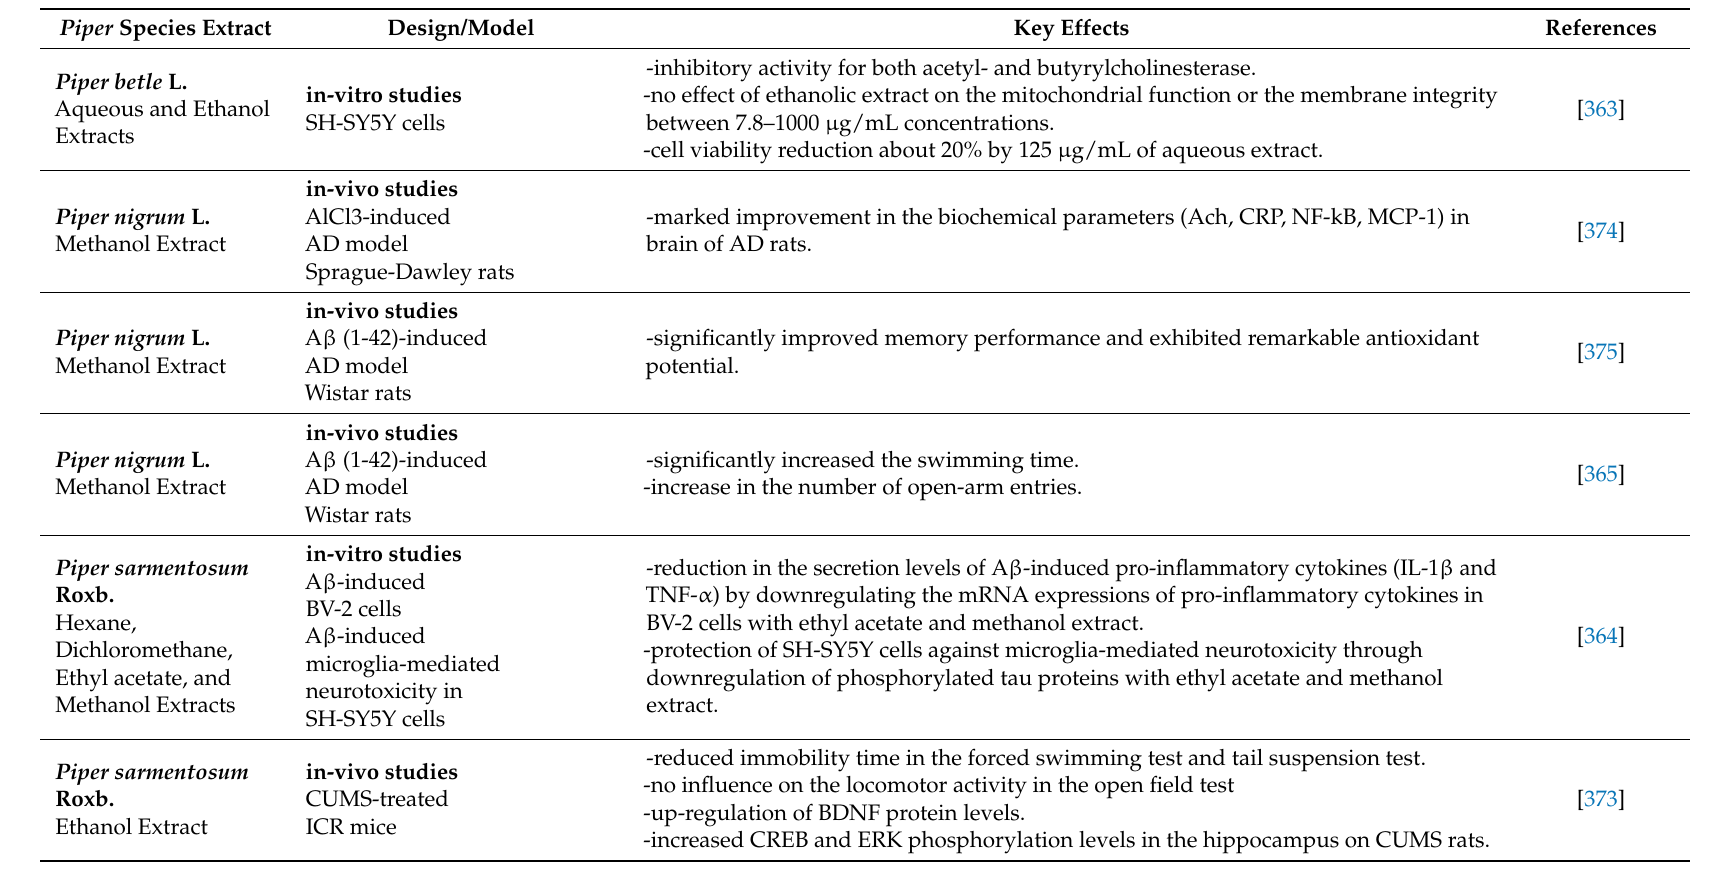
Table 32. Neuropharmacological activities of different Piper